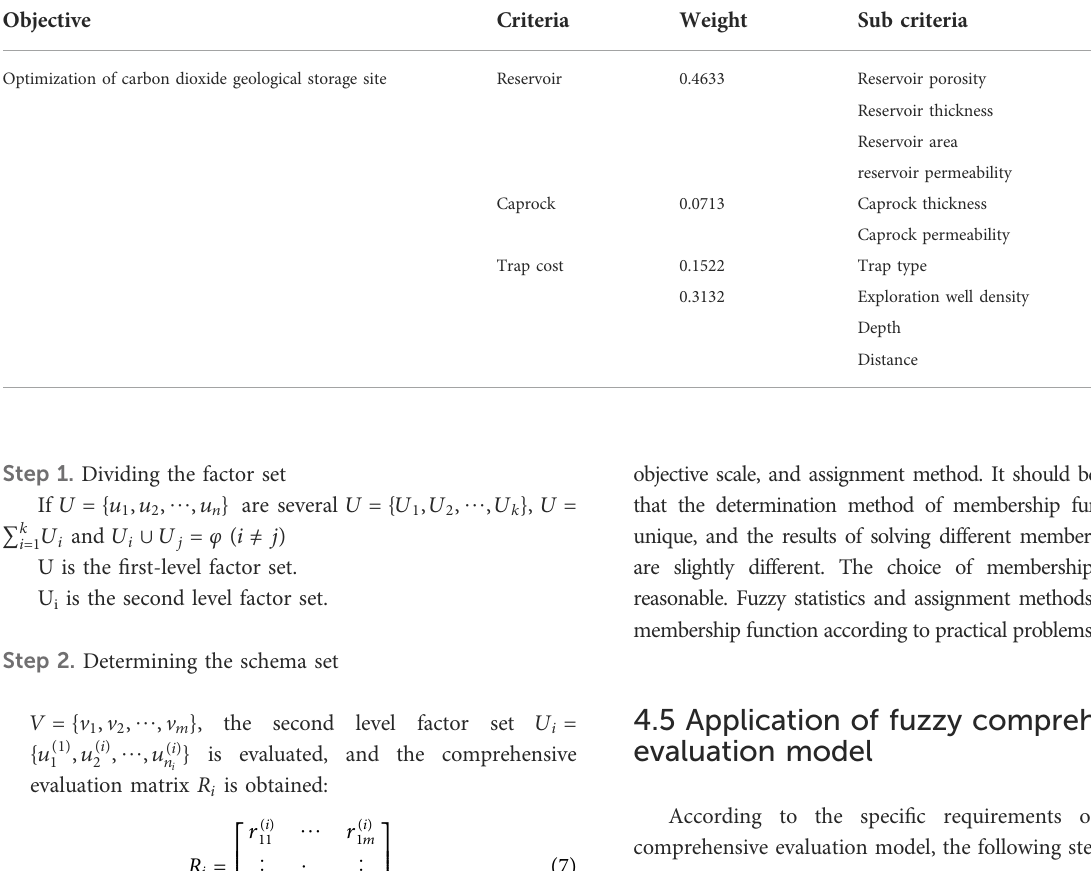
TABLE 6 Weight value of each